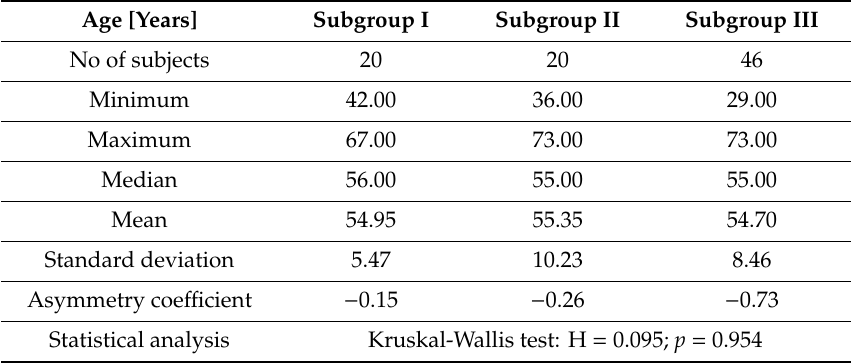
Table 2. Analysis of age of the study population divided into three subgroups.